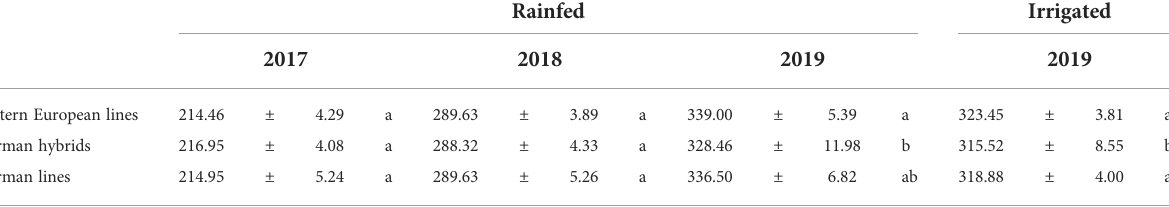
TABLE 5 Accumulative canopy temperature (CT) of Eastern European lines, German hybrids, and German lines measured with a handheld camera from anthesis until harvest under rainfed conditions in 2017, 2018, and 2019 and under irrigated conditions in 2019.